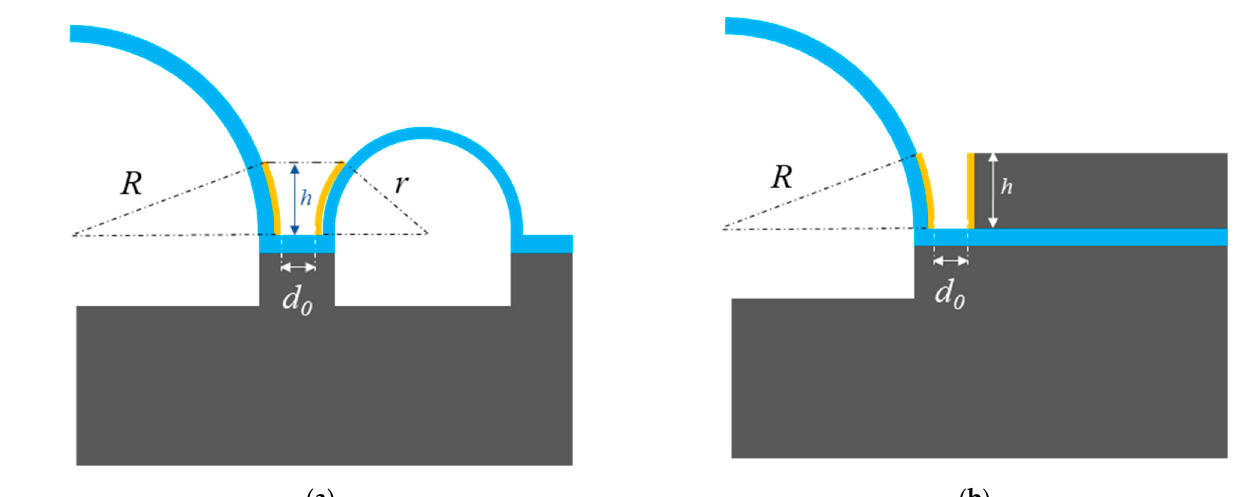
Figure 4. Comparison of μ HR s with annular electrodes and silicon-based electrodes ( a ) annular electrodes; ( b ) silicon- based electrodes.